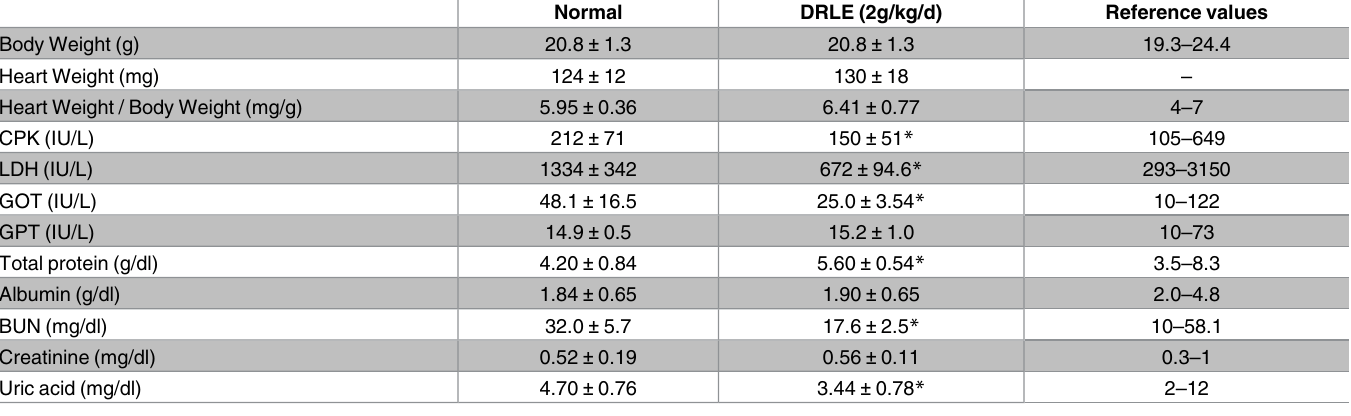
Table 1. Body Weight and Serum Biochemical Markersin Oral Toxicity Test of